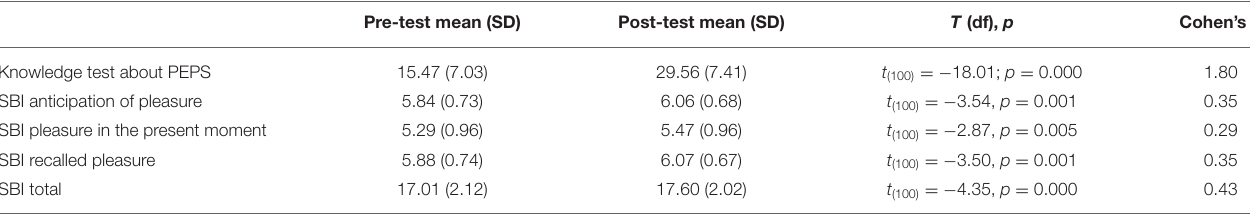
TABLE 1 | Pre and post-tests